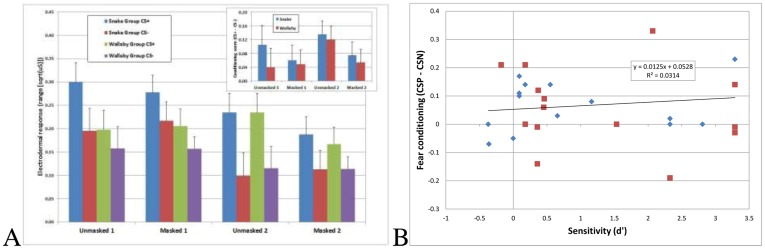
Electrodermal responses to masked and unmasked stimulus presentations (A) and scatter plot of d′ scores in a classification task (snake/wallaby) for masked images against individual conditioning scores for masked trials (B).CS+ electrodermal responses (A) are heightened relative to CS- responses. This is true regardless of whether the CS+ was a snake (blue and red bars) or a wallaby (green and purple bars). This was also true across all four blocks of trials, including blocks of masked image presentations. The insert depicts conditioning scores (response to CS+ - response to CS-) as a function of Group and Block. Error bars depict +1 SEM. The scatterplot of individual conditioning scores against classification sensitivity (B) reveals no correlation, showing that people did not have to be aware of the species depicted in the masked image in order to display differential fear conditioning.